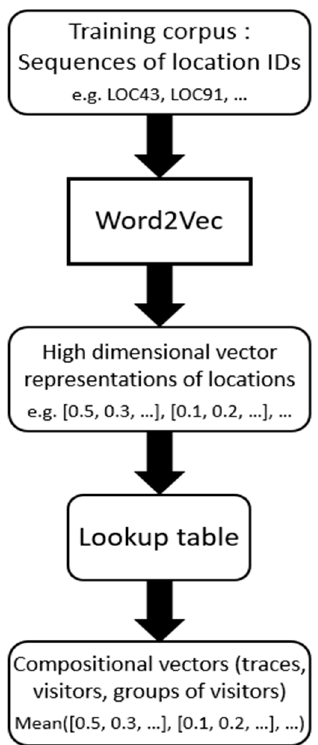
Figure 5. Overview of the embedding generation steps. Step 1: vector representations of locations are generated by means of an unsupervised training process. Step 2: location vectors are retrieved and averaged to obtain trace and visitor vectors.